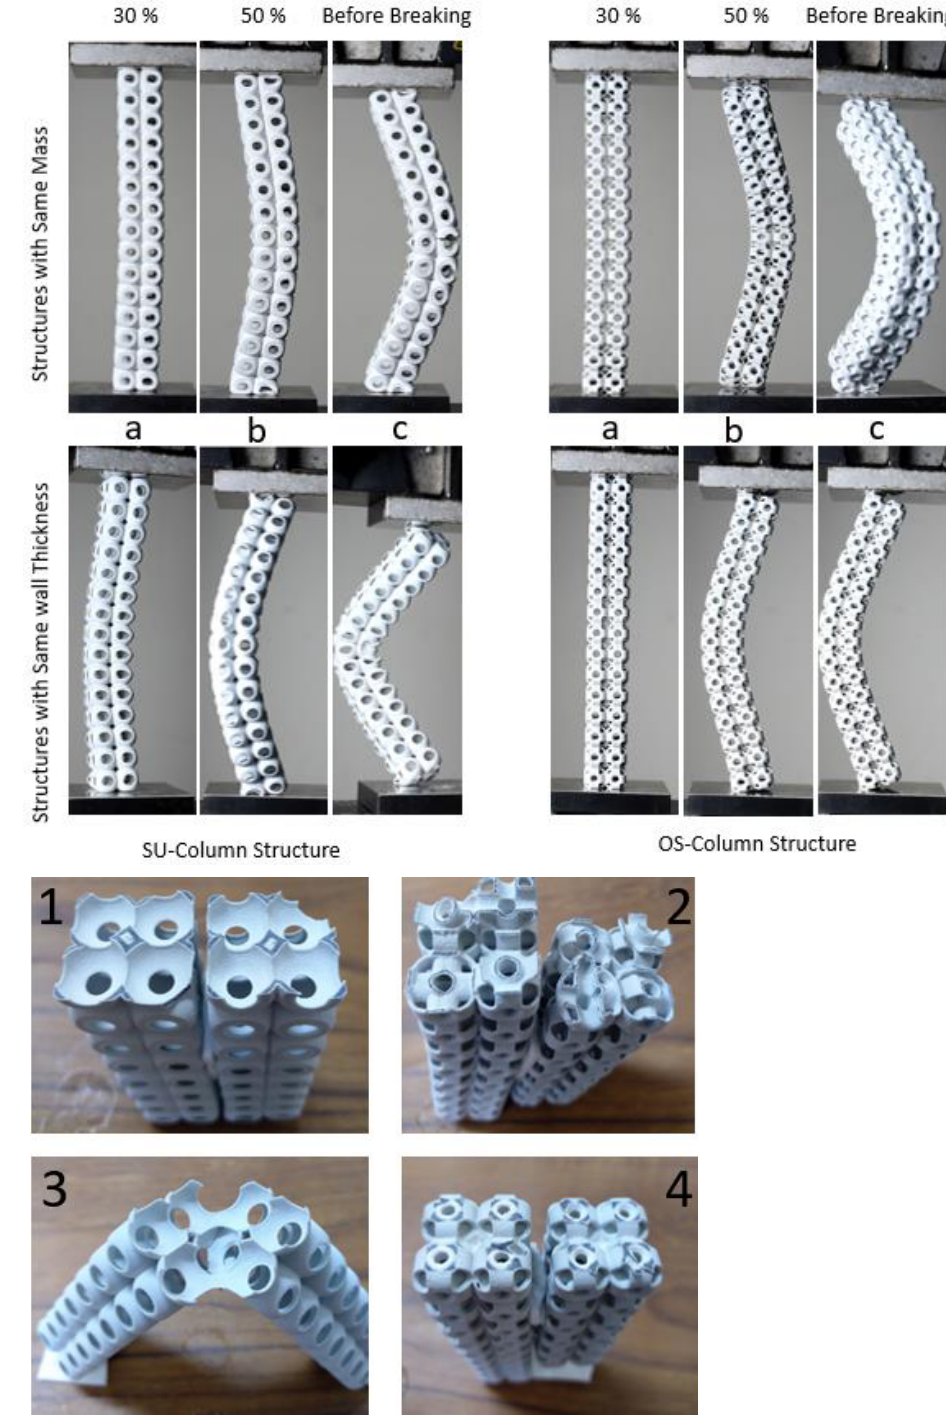
Figure 9. The figure ( above ) shows the overall buckling of each 2 × 2 × 15 structure under percent- ages of compression. While the ( below ) figures show an inner failure mechanism ((1) and (3) shows failure of SU structure while (2) and (4) shows the failure of OS structure) of the structure in which all (M and T) failed at the cell center, only OS-T is failed at the cell joints.